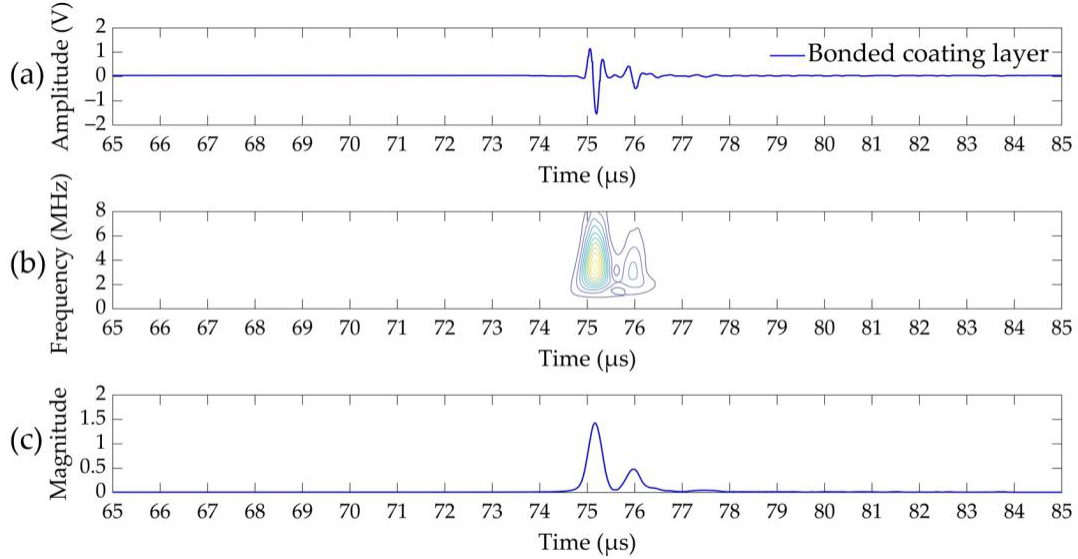
Figure 6. Time-domain waveform from bonded coating layer ( a ), the CWT of the time domain waveform ( b ), and the projection of the CWT magnitude to the time domain ( c ).